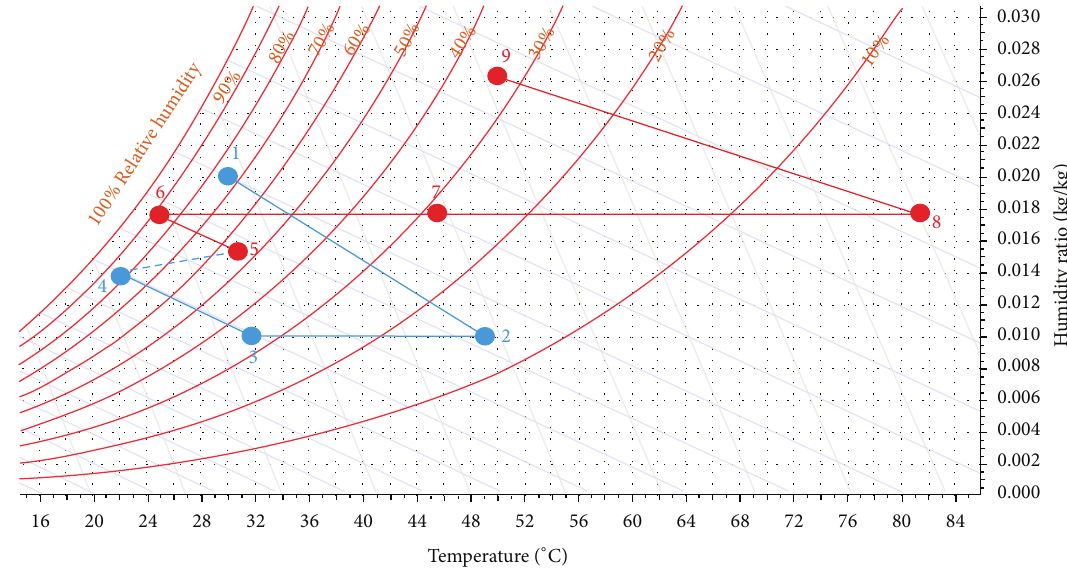
Figure 7: Psychometric chart of the one-stage solar desiccant cooling system under the ventilation mode.